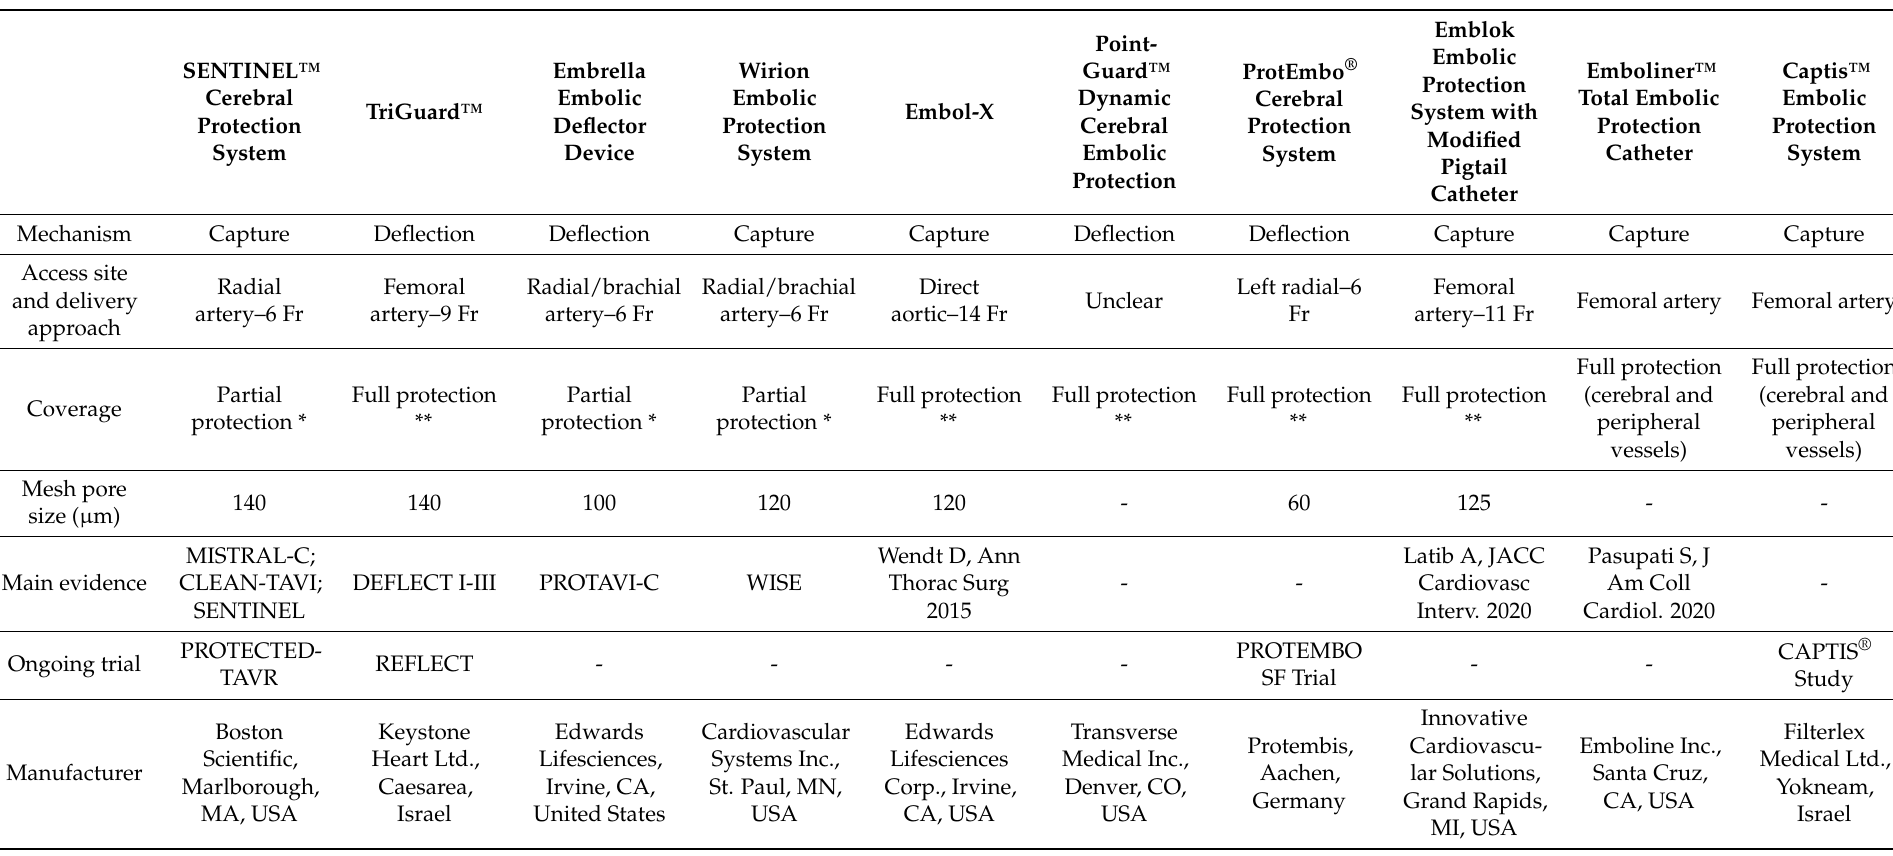
Table 1. Cerebral Protection Devices. * Two vessel protection (brachiocephalic and left common carotid artery); ** Three vessel protection (brachiocephalic, left common carotid and left subclavian artery). Fr =